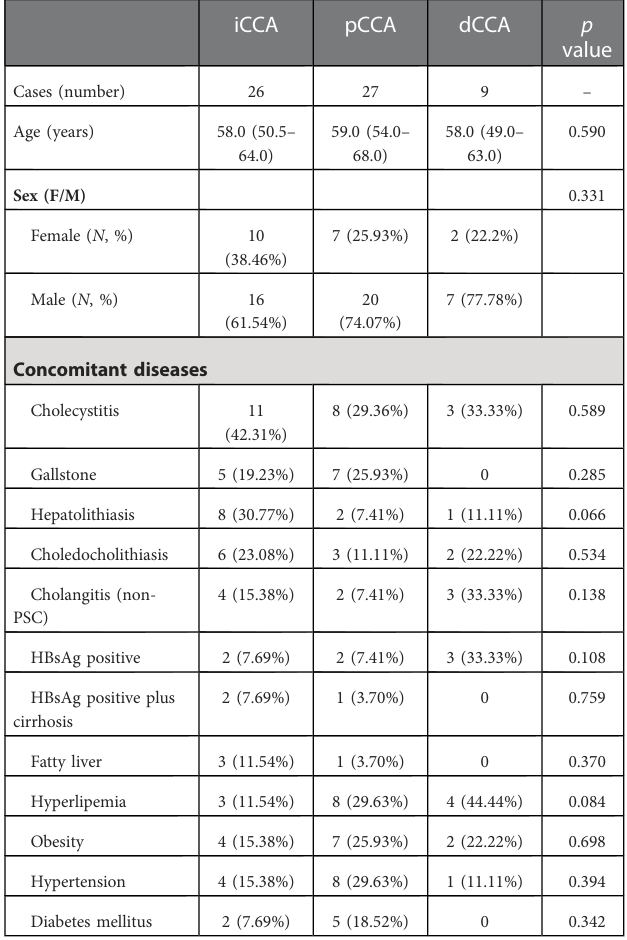
TABLE 1 Demographics of CCA patients in this study. Liver function in CCA patients pCCA Notably, CCA patients develop obstructive jaundice as the disease progressed and produces obstruction of both right and left hepatic ducts or the common hepatic duct in the case of pCCA or the common bile duct in the case of dCCA. iCCA